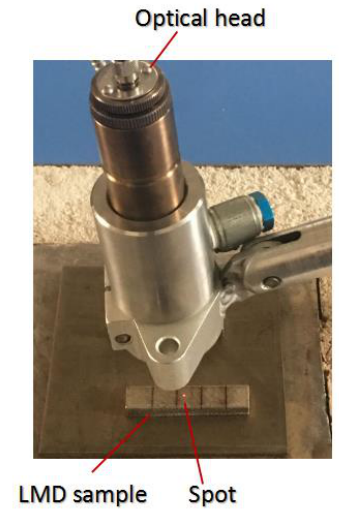
Figure 2. LMD specimen surface temperature collection by the IMP.